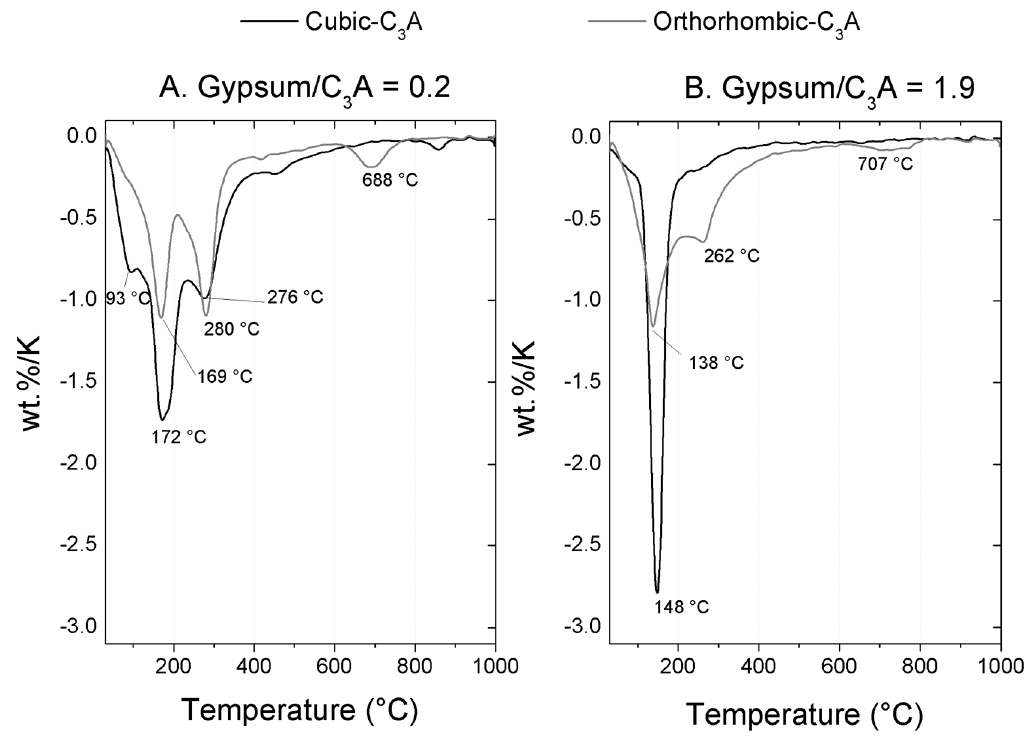
Figure A1. Derivative Thermogravimetric analyses of cubic and orthorhombic C 3 A and gypsum at a ratio of: ( A ) 0.2; and ( B ) 1.9 after three days of curing.